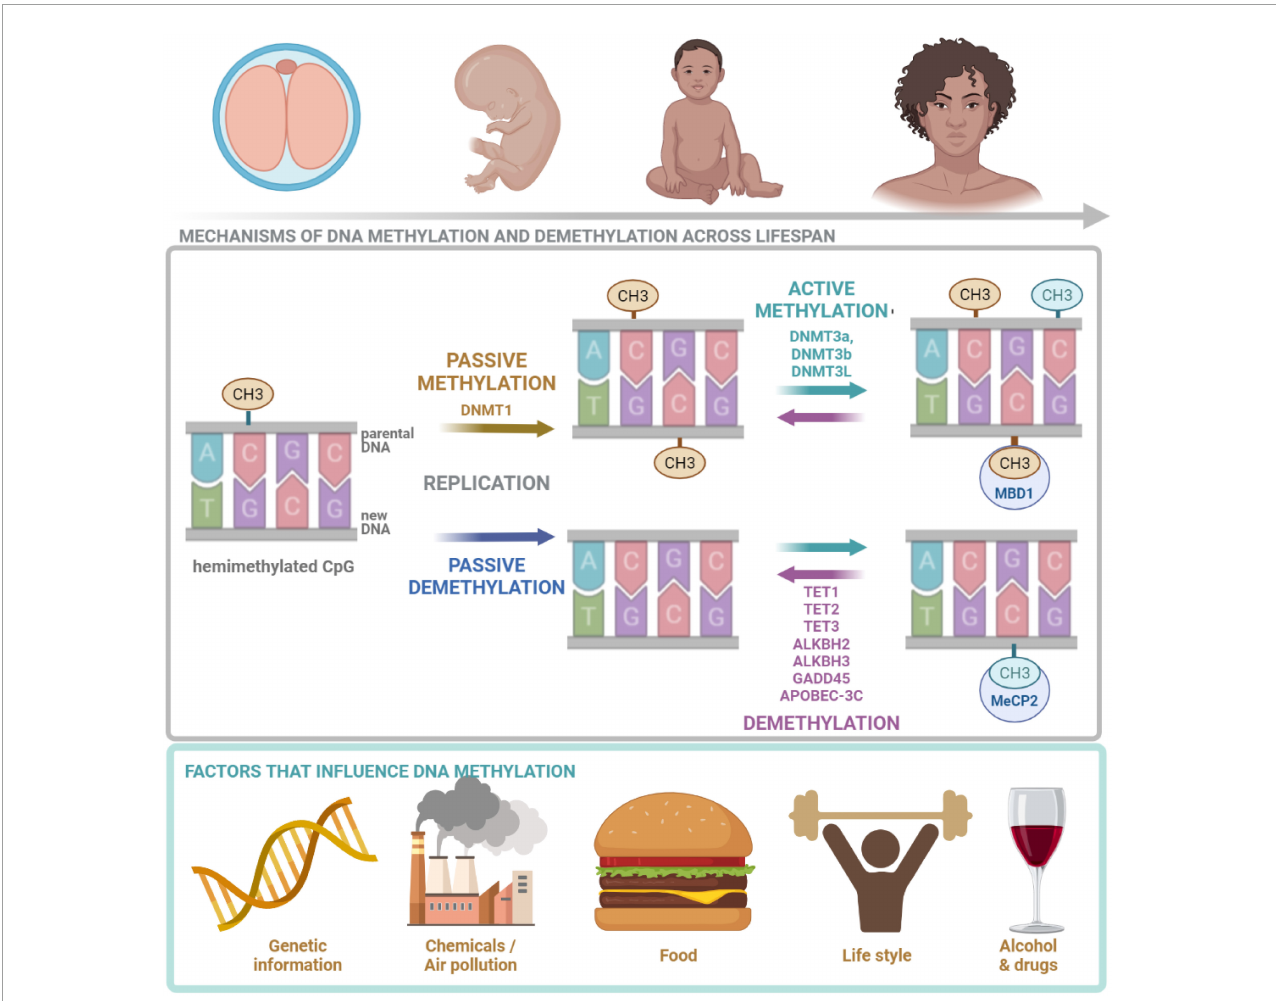
FIGURE2 DNA methylation across lifespan. DNA methylation is crucial at all stages of human life. It is regulated by many factors including: genetic landscape, air pollution, diet, lifestyle as well as drugs and alcohol. DNMT1, responsible for maintenance methylation, acts on the hemimethylated CpG site generated by the replication. DNMT3a and DNMT3b, responsible for de novo methylation, attach methyl groups in unmethylated CpG sites. DNA methylation may be passive, defined as the failure of maintenance methylation after DNA replication or active, independent to replication, carried out by several enzymes. Demethylation process is carried out and controlled by TETs. MeCP2 is able to bind specifically to methylated DNA and repress transcription from methylated gene promoter. CH3, methyl group; CpG, cytosine/guanine site; DNMT1, DNA methyltransferase 1; DNMT3a, DNA methyltransferase 3a; DNMT3b, DNA methyltransferase 3b; DNMT3, DNA methyltransferase 3L; TET1, TET methylcytosine dioxygenase 1; TET2, methylcytosine dioxygenase 2; TET3, methylcytosine dioxygenase 3; ALKBH2, alpha-ketoglutarate-dependent dioxygenase AlkB homolog 2; ALKBH3, alpha-ketoglutarate-dependent dioxygenase AlkB homolog 3; GADD45, growth arrest and DNA damage inducible protein 45; APOBEC-3C, apolipoprotein B mRNA-editing enzyme complex; MeCP2, Methyl-CpG binding protein 2. The figure is made in Bio